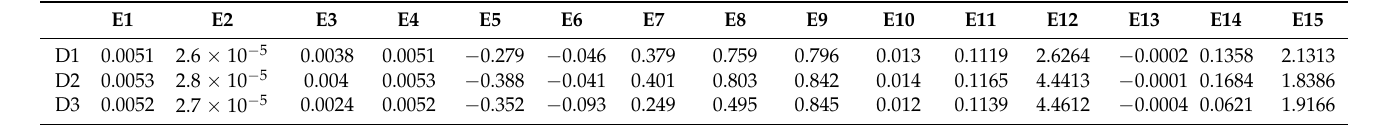
Table 21. Error measures in predicting test log returns for the three datasets.